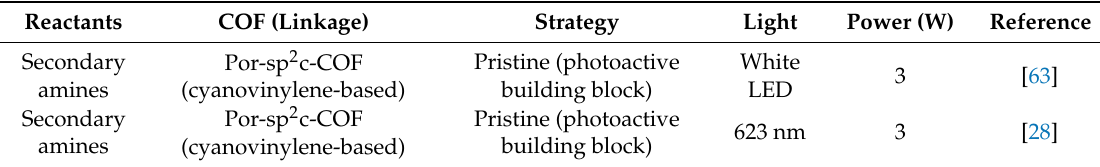
Table 6. Photooxidation reactions of secondary amines mediated by